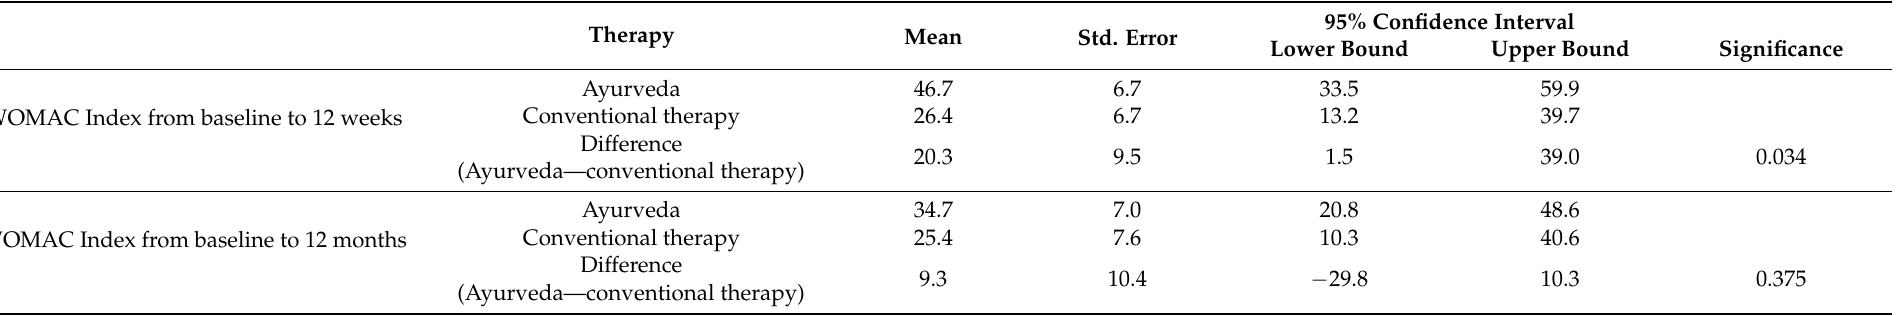
Table 1. Estimated marginal means of changes in the WOMAC Index from baseline to 12 weeks and to 12 months, standard error, 95% CI, mean difference based on the marginal means and significance for the mean difference. Therapy, gender, and patients’ expectations for therapies received as fixed factors and